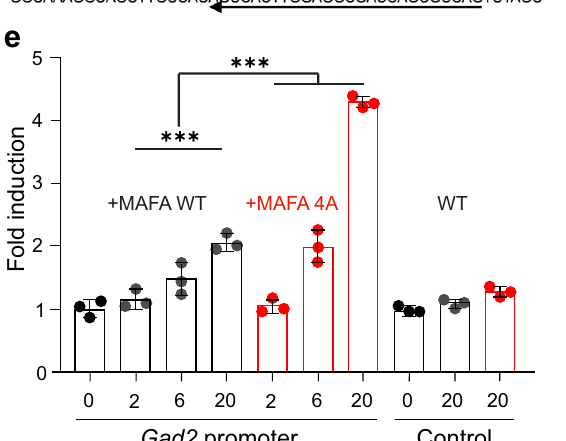
synthesis. We fi rst con fi rmed qualitatively by ISH that inhibitory Mafa + neurons in the medulla in Mafa null mutants, expressed lower amounts of Gad2 transcripts compared to heterozygous Mafa LacZ/ + littermates (Fig. 5a). We next performed RT-qPCR to assess quantitatively the hypothesis that in Mafa 4A/4A mutants, the higher rates of Mafa would result in augmented Gad2 synthesis. To do this, plasmids encoding wildtype (WT) or Mafa-4A were transfected into a human neuronal cell lines